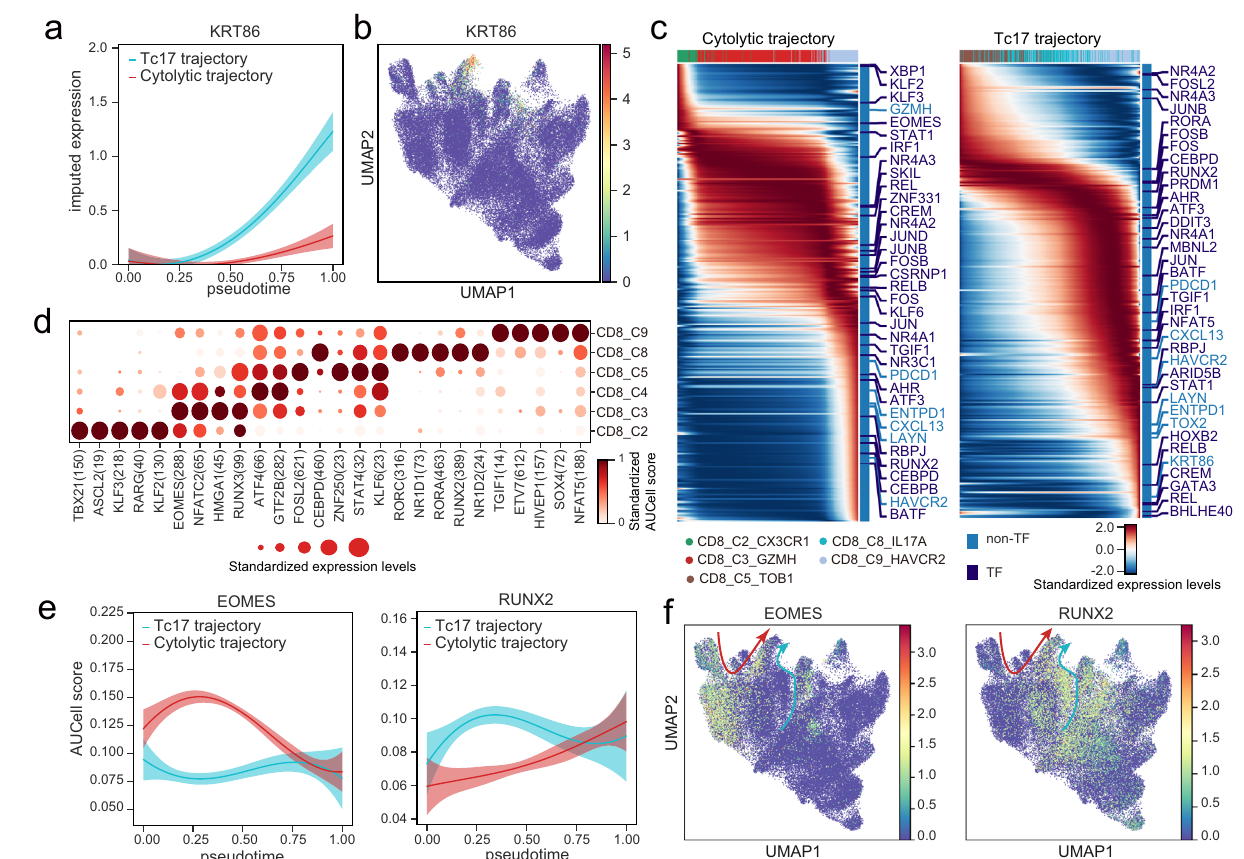
Fig. 7 | Dynamics of TF activities along the T-cell exhaustion trajectories and the potential promoting effect of IL17 + T cells on gastric tumors. a Gaussian process regression curves with a 95% con fi dence interval showing the dynamic expression of KRT86 along the pseudotime of the cytolytic trajectory (excluding CD8_C4_GZMK)and the Tc17 trajectory. b UMAP showing the expression of KRT86 in T cells. c Heatmaps showing the expression of highly variable genes along the pseudotime of the cytolytic trajectory (excluding CD8_C4_GZMK) and the Tc17 trajectory. The color bar on the top represents cell clusters as in Fig. 6g; The color bar on the right annotates all the highly variable TFs and some speci fi c marker